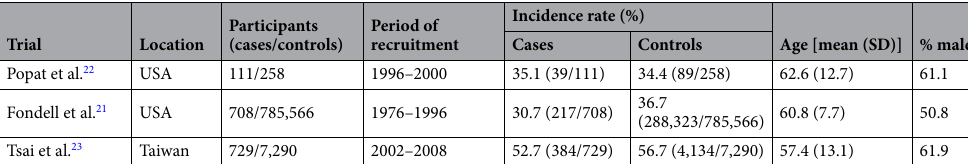
Table 1. Characteristics of case control trials assessing non-aspirin NSAIDs use and incidence of ALS in the systematic